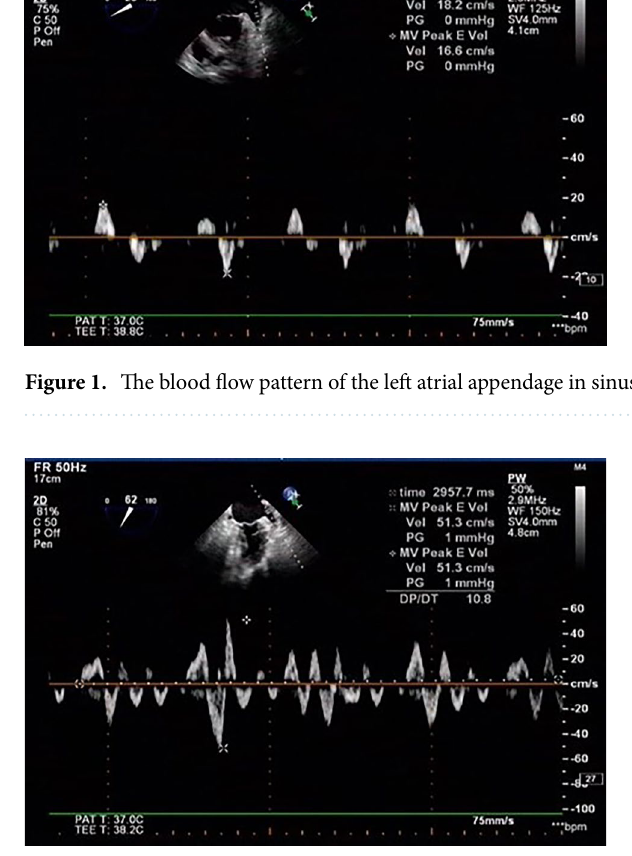
Figure 2. The blood flow pattern of the left atrial appendage in atrial fibrillation